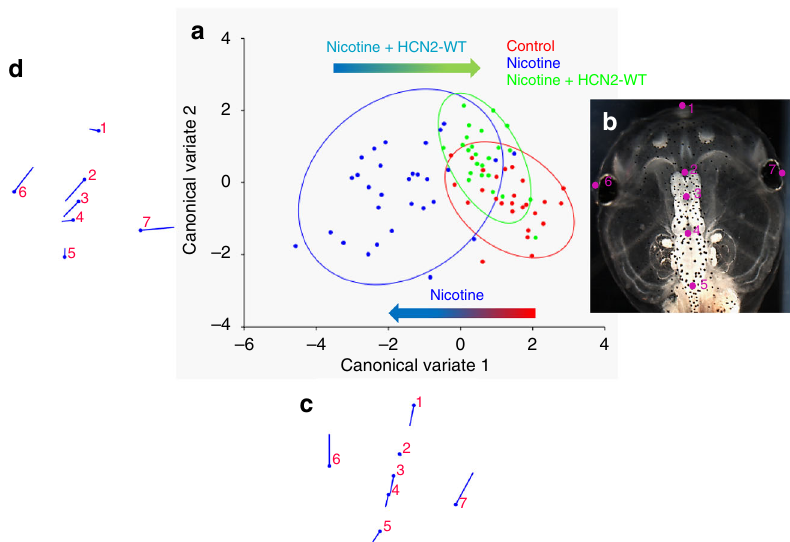
Fig. 6 HCN2 channels restore the brain size relation to anterior head shape in nicotine-exposed embryos. Morphometrics canonical variate analysis of brain size relation to anterior head shape of stage 45 tadpoles. a Graphical output, showing con fi dence ellipses for means, at a 0.95 probability, of shape data from controls and nicotine-exposed (0.1 mg/mL – stage 10 – 35) tadpoles with or without Hcn2-WT mRNA (0.75 ng/injection) microinjected in both blastomeres at 2-cell stage. Ellipses are colored to correspond with treatment as indicated. N > 26 for each group. Procrustes distances show objective alteration of brain size in relation to head morphology by nicotine exposure in relation to controls as indicated by the red-blue arrow. Hcn2-WT mRNA microinjection along with nicotine exposure moves the brain size — head shape relation closer to controls as indicated by the blue-green arrow. b Stage 45 control tadpole image illustrating the 7 landmarks considered for this analysis comparing brain size and head shape. Landmarks 2, 3, 4, and 5 show the start of forebrain, transition to midbrain, transition to hindbrain, and end of hindbrain, respectively. Landmarks 1, 6, and 7 indicate the anterior most, and lateral most points of the head shape. c Canonical variate 1 axis legends (ball and stick diagrams) showing movement of each of the 7 landmarks in mainly anterior-posterior direction. Each ball represents the landmark as indicated by the number and the accompanying stick represents the direction and extent of movement of that particular landmark. d Canonical variate 2 axis legends (ball and stick diagrams) showing movement of each of the 7 landmarks in mainly lateral direction. Each ball represents the landmark as indicated by the number and the accompanying stick represents the direction and extent